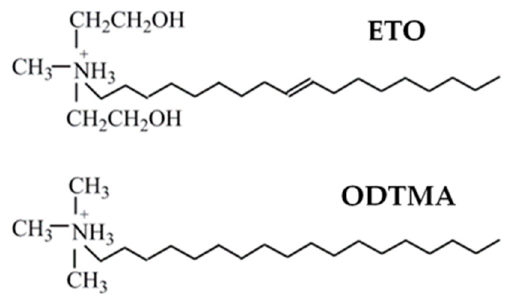
Figure 1. Chemical structures of organic modifiers of vermiculite (VMT).